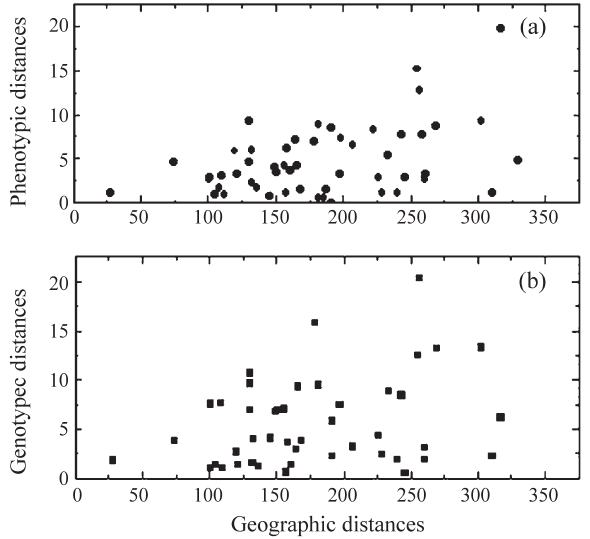
Figure 2 - Relationship between the Mahalanobis phenotypic (a) and genotypic (b) variation (Y axis) and the geographic distances (X axis) among the 13 Eugenia dysenterica DC